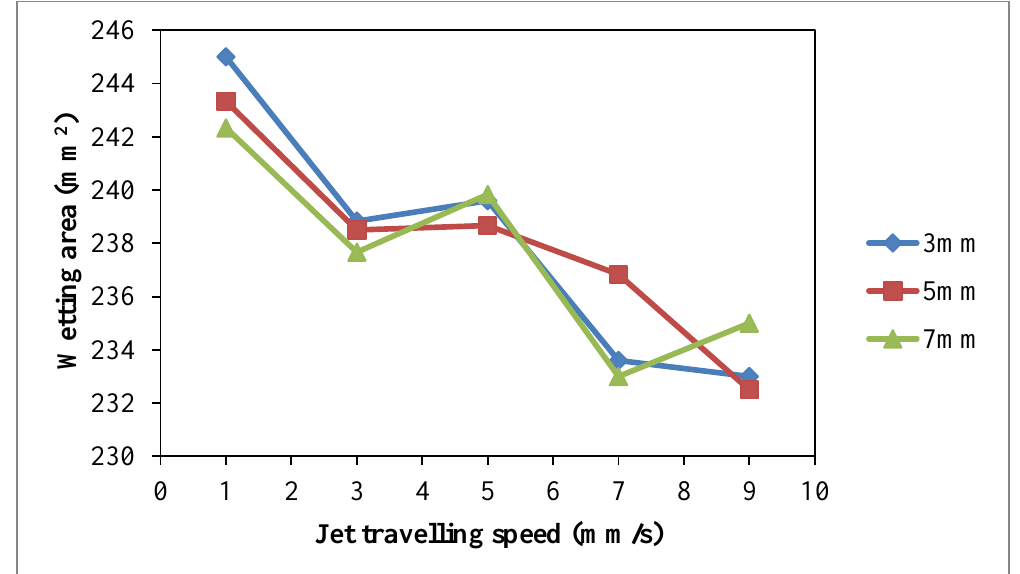
Figure 13. Effect of jet travelling speed on wetting area (Jet travelling speed: 1 mm/s, 3 mm/s, 5 mm/s, 7 mm/s and 9 mm/s; Jet-to-substrate distances: 3 mm, 5 mm and 7 mm; Discharge power: 150 W and Oxygen flow rate: 0.4 L/min).